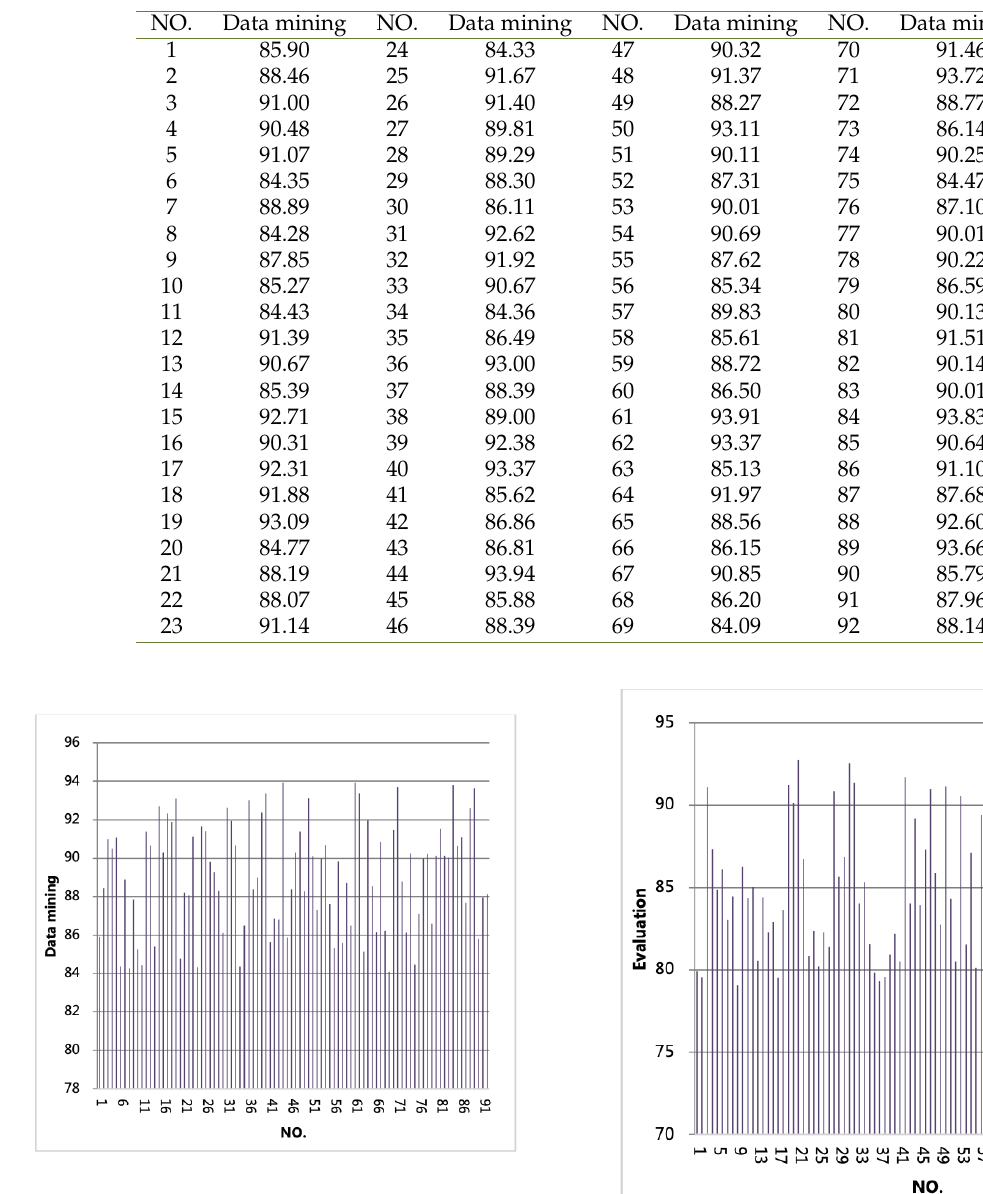
Table 1. Statistical table of the evaluation of data mining ability